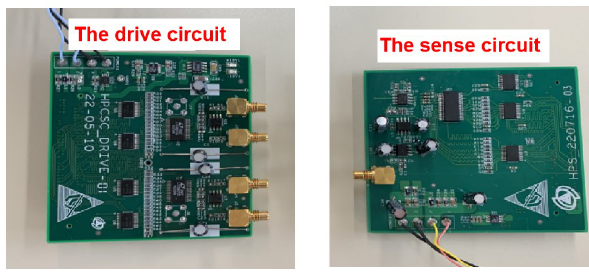
Figure 16. PCB of the signal processing circuit.